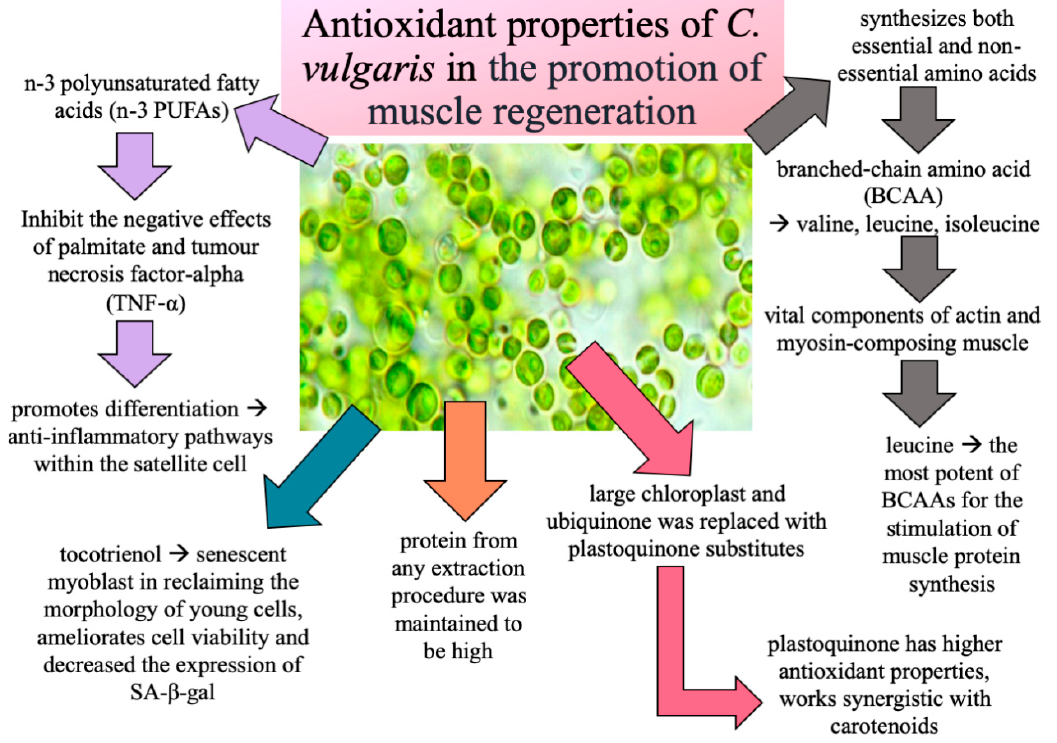
Figure 6. The antioxidant properties of C. vulgaris and its effect in promoting muscle regeneration